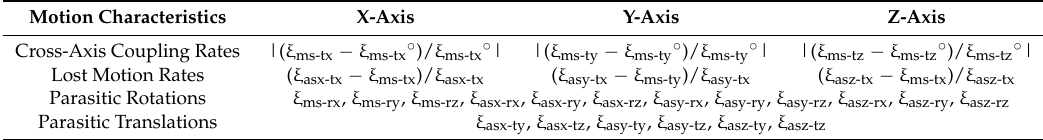
Table 1. Representation or calculation of the four motion characteristics of an XYZ